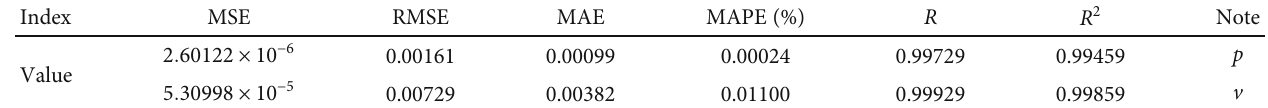
Table 3: Regression evaluation of the genetic algorithm for the numerical data.